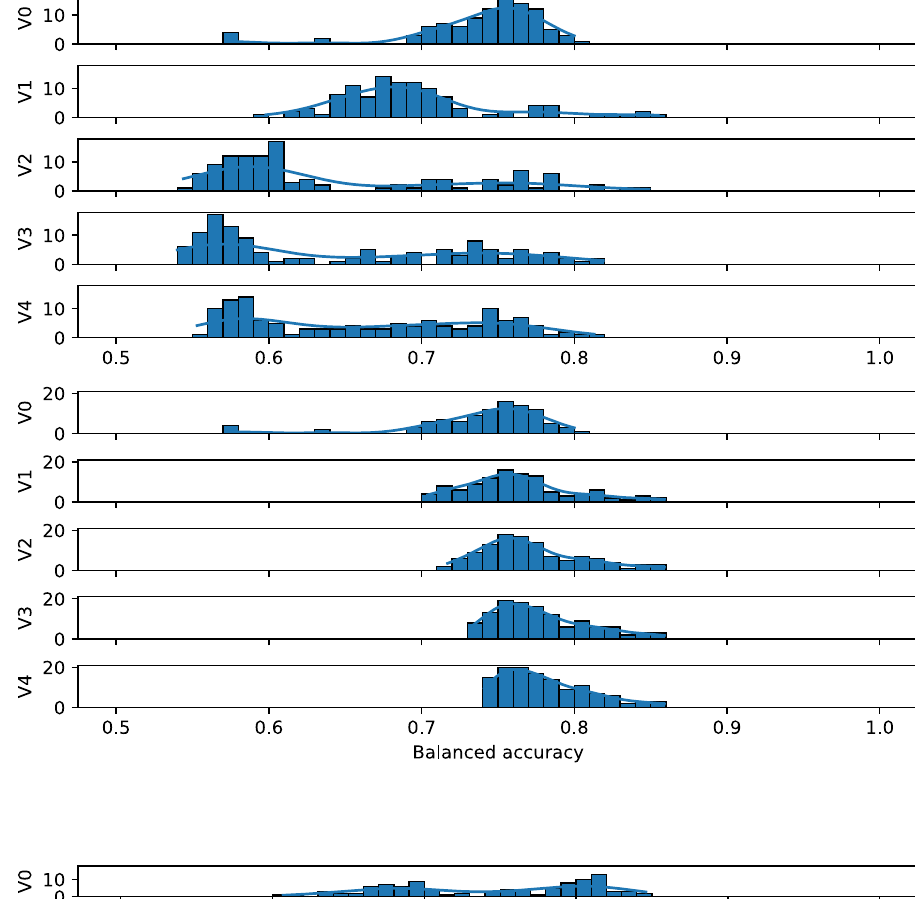
Fig. 5 Histogram of the bal- anced accuracy of trees in the Occupancy dataset. Update metrics on top, no update